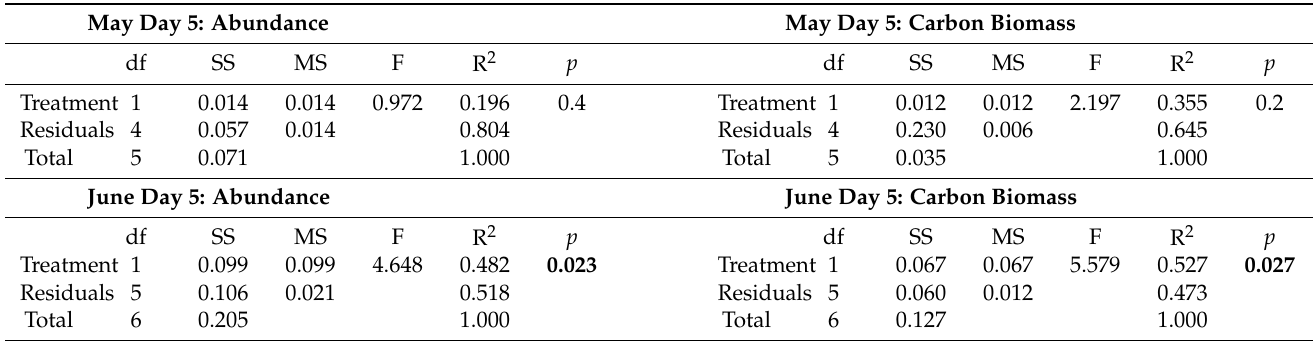
Figure 6. Microplankton taxa total abundance ( left ) and carbon biomass ( right ) for Day 5 final control and final nutrient-amended samples. Rhodophytes were not present in any Day 5 sample and are therefore not shown. Asterisks indicate statistically significant p -values for t -tests comparing final control and final nutrient-amended samples. t -tests were performed on square-root transformed abundance and log(x + 1) transformed biomass. p < 0.05 = *, p < 0.01 = **, p < 0.001 = ***. Table 3. Results of PERMANOVA tests for the effect of nutrient amendment on Day 5 microplankton assemblage structure for each month using square-root transformed taxa abundances and log(x + 1) biomasses. Statistically significant p -values are in